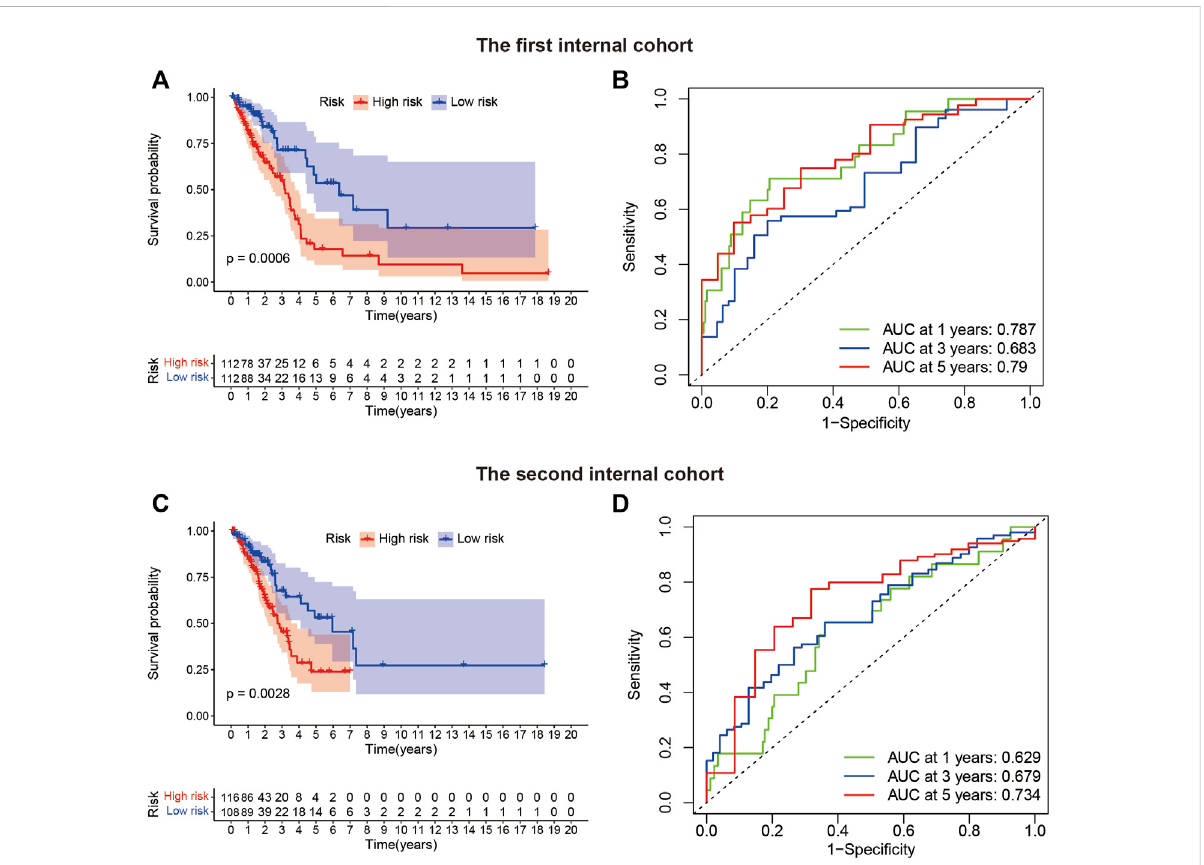
FIGURE 8 InternalvalidationofLUADSenLncSigforOS. (A) Kaplan – Meiersurvivalcurvesforthe fi rstinternalcohort(n=224). (B) Inthe fi rstinternalcohort, the ROC curve and AUC at 1-year, 3-year, and 5-year survival were calculated. (C) Kaplan – Meier survival curves for the second internal cohort (n = 224). (D) In the second internal cohort, the ROC curve and AUC at 1-year, 3-year, and 5-year survival were calculated. Lnc, long non-coding; LUAD, lung adenocarcinoma; LUADSenLncSig, LUAD senescence lncRNA signature; ROC, receiver operating characteristic; AUC, area under the curve; OS, overall survival; TCGA, The Cancer Genome